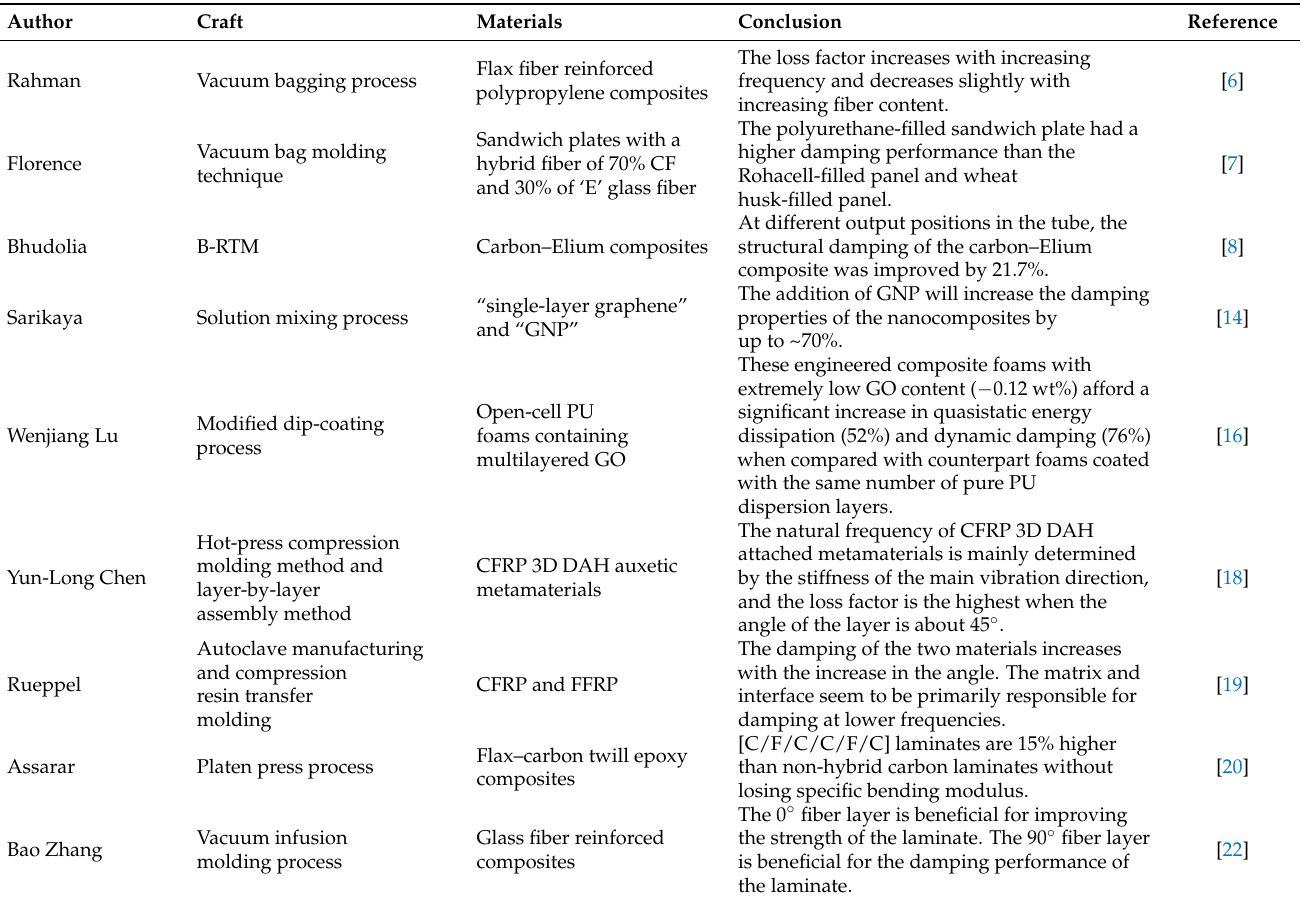
Table 1. A comparative table of recent research results on damping properties of composite